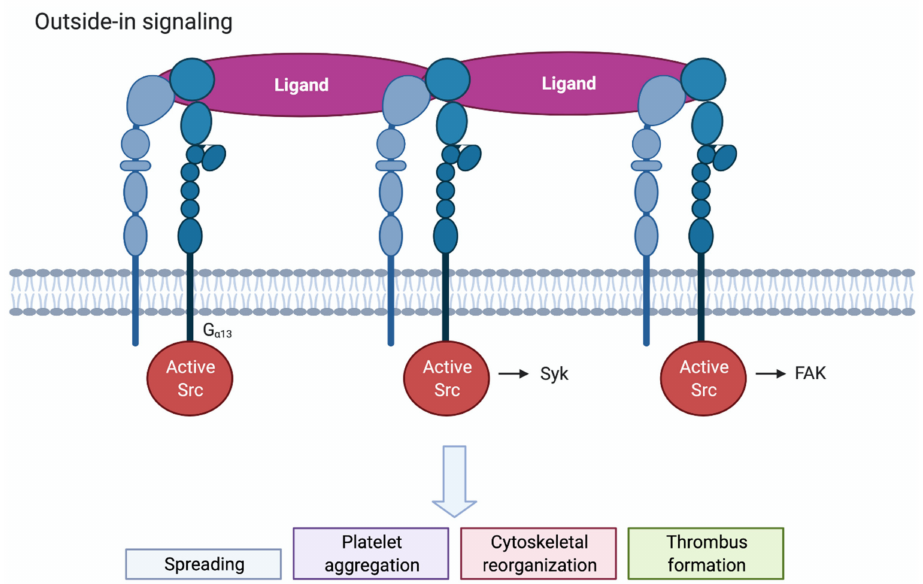
Figure 3. Schematic overview of outside-in signalling in platelets. Clustered integrins will initiate outside-in signalling. c-Src associates with the β 3-integrin tail and becomes activated. Src, Syk and FAK will regulate downstream signalling via tyrosine phosphorylation. Outside-in signalling leads to spreading, platelet aggregation, cytoskeletal reorganisation and thrombus